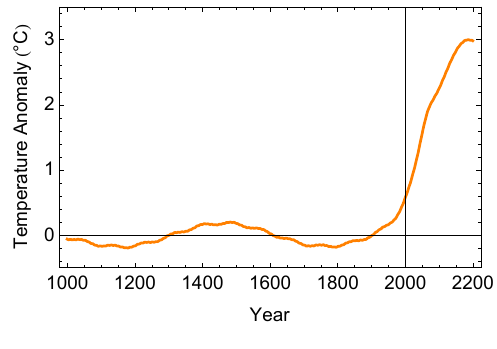
Figure 2. Temperature changes with stratospheric sulfur injection, followed later by carbon